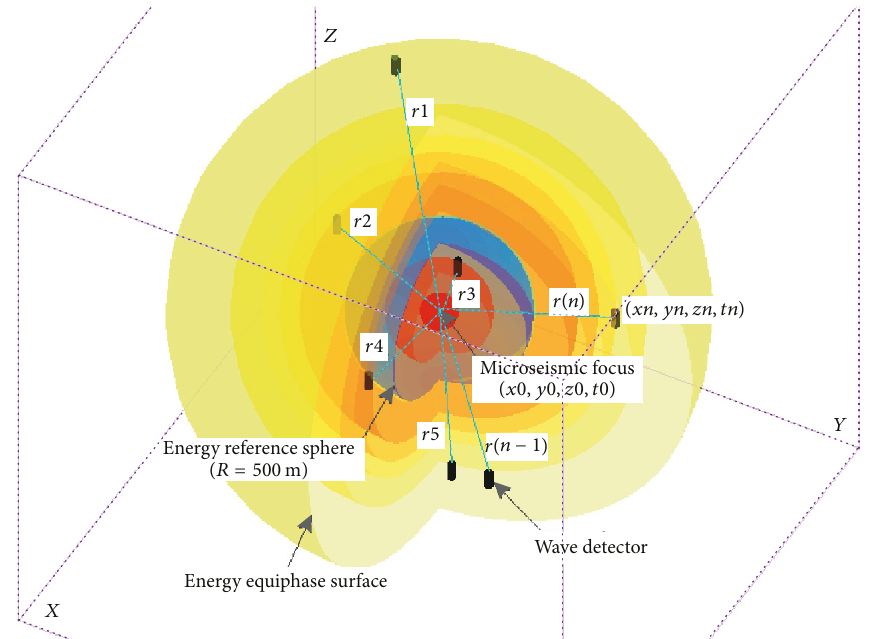
Figure 1: Energy emission of microseismic event in deep rock and the reference sphere model for focus energy